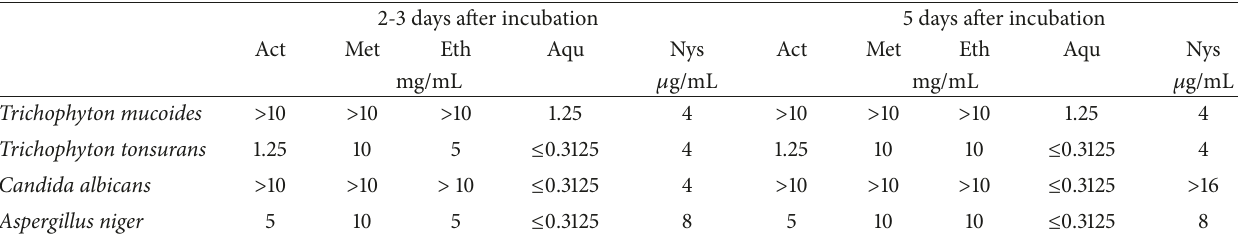
Table 3: Minimum Inhibitory Concentrations (MIC) of the different solvent extracts of P. capitata on selected human pathogenic fungi. 2-3 days after incubation 5 days after